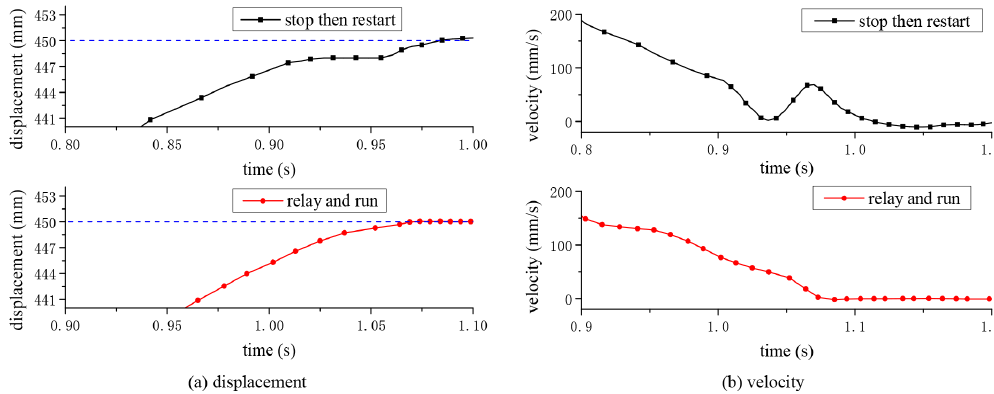
Figure 21. Comparison of the positioning test of 0–450mm with the strategies of relay and run and stop then restart.